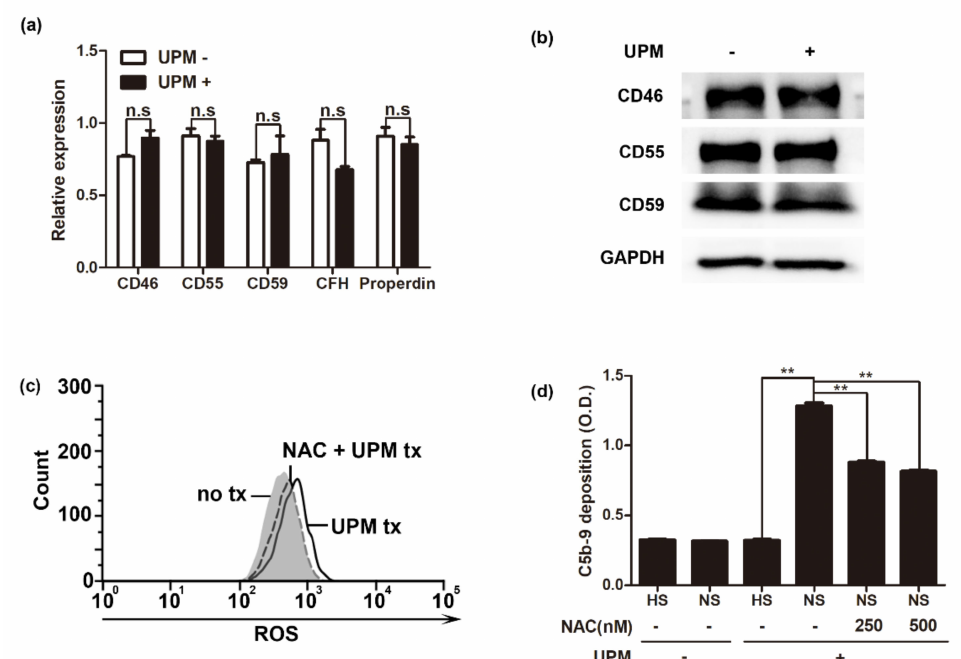
Figure 3. Complement activation in UPM-treated HUVECs is mediated by reactive oxygen species (ROS) production and not complement regulatory proteins ( a ) The mRNA expression of CD46, CD55, CD59, and factor H in UPM-treated HUVECs. Relative expression of each indicated protein was analyzed by reverse transcription (RT)-quantitative PCR. Results are shown as mean ± SD, n = 3, Student’s t -test. n.s: not significant. ( b ) Western blot analysis for CD46, CD55, and CD59 protein expression in UPM-treated HUVECs. ( c ) Cellular ROS production in UPM-treated HUVECs. HUVECs were labeled with CellROX Green reagent and analyzed by flow cytometry. N-acetylcysteine (NAC) was added for 3 h before UPM treatment. Gray: untreated HUVECs (control). Black dot line: NAC-treated HUVECs with UPM (NAC + UPM), black line: HUVECs with UPM (UPM). ( d ) Analysis of C5b-9 depositions on NAC-treated HUVECs with/without UPM using a cell-based enzyme-linked immunosorbent assay. Results are shown as mean ± SD, n = 5, Student’s t -test (HS vs. NS) or one-way ANOVA with multiple comparisons. ** p <